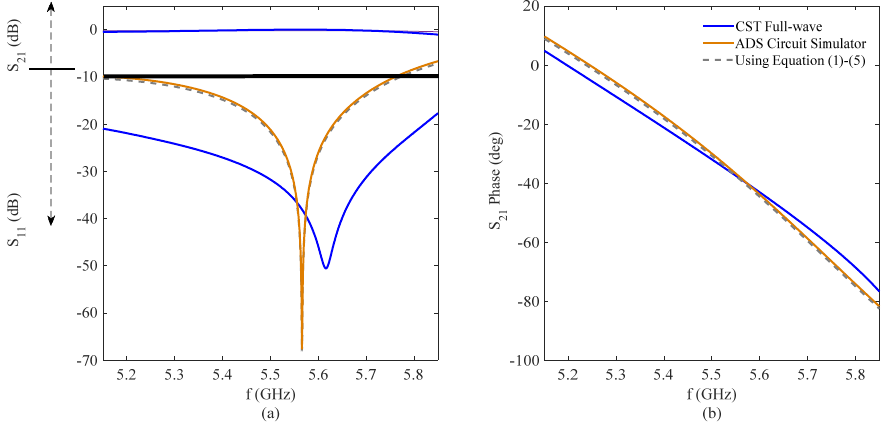
Figure 3. ( a ) Reflection coefficient, insertion loss, and ( b ) phase response of the unit cell P-CRLH phase shifter with MRSs 1 & 9 activation.